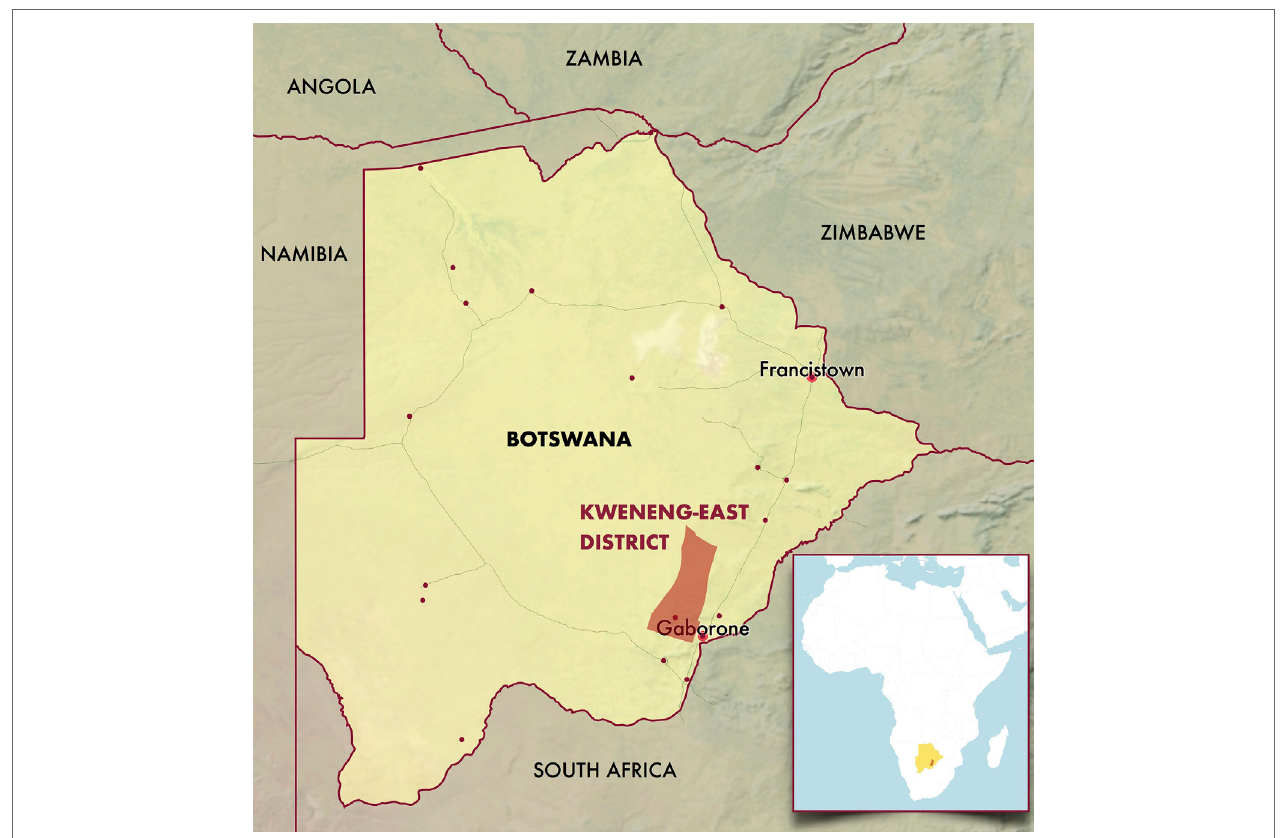
FigUre 1 | Map of Botswana and Kweneng-East